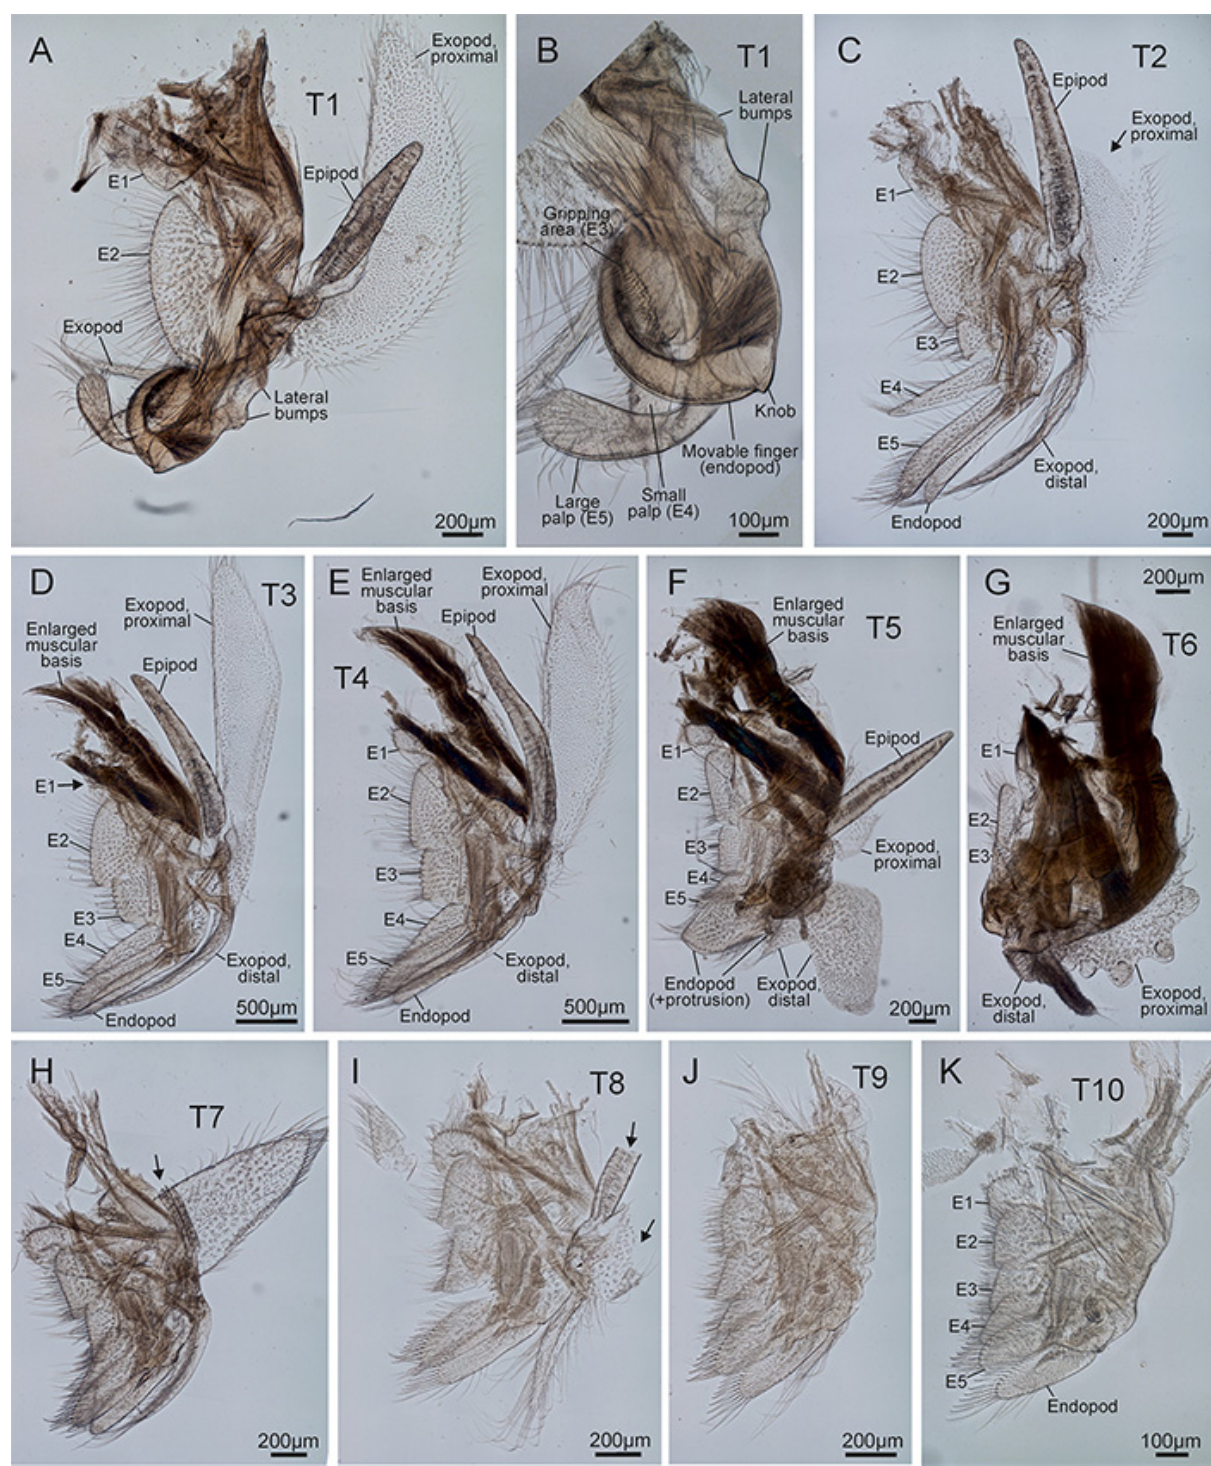
Figure 8. Lynceus grossipedia n. sp., male, light microscopy of left side thoracopods, seen from anterior (paratype, NHMD-616086). A. Thoracopod I (male clasper). B. Higher magnification of clasper. C–K. Thoracopods II–X of which III–VI (D–G) are modified, not least with notably enlarged muscular bases. F. Thoracopod V with endopod and distal part of exopod explanate. G. Thoracopod VI with exopod proximal part with ~7 knob-shaped processes and distal part highly setose (seen better on SEM images, Fig. 7H), endites 4–5 and endopod non-visible as folded behind thoracopod. Arrows indicate broken/hidden